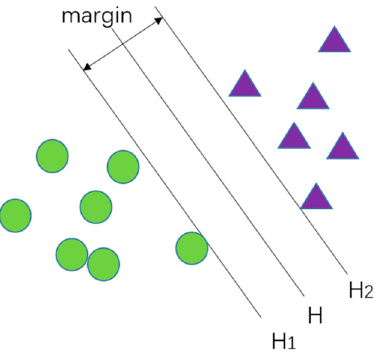
Figure 8. Schematic diagram of optimal classification line.